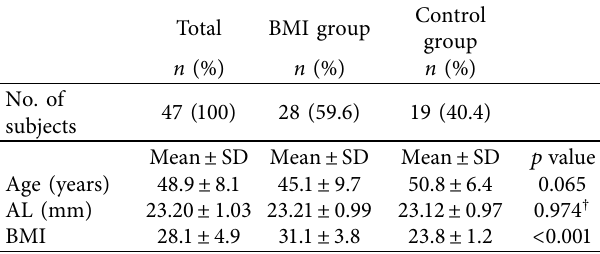
Table 1: Overall and group characteristics ( n � 47).